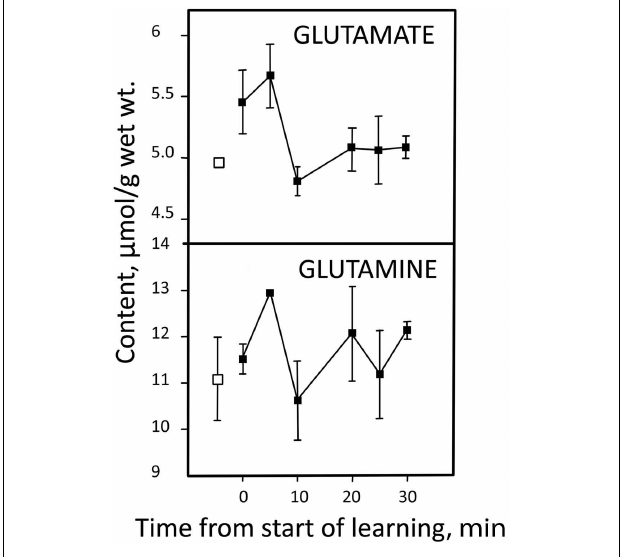
FIGURE 2 | Learning-induced changes in glutamate and glutamine content in the equivalent of the mammalian brain cortex in day-old chicken . Pre-learning contents are indicated by open symbols and post-learning contents with filled-in symbols. From Hertz et al.